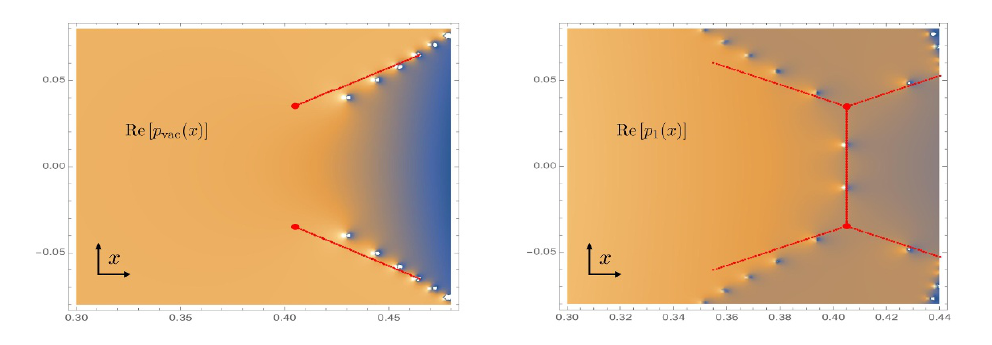
Figure 17 . Accessory parameters associated with the exact blocks at (cid:12)nite c . Left: real part of p vac ( x ); right: real part of p 1 ( x ). Red curves are the anti-Stokes rays predicted in (6.7). Parameters used: c = 1000 ; (cid:15) L = 1 = 200 ; (cid:15) H = 36, branch points at x (cid:6)